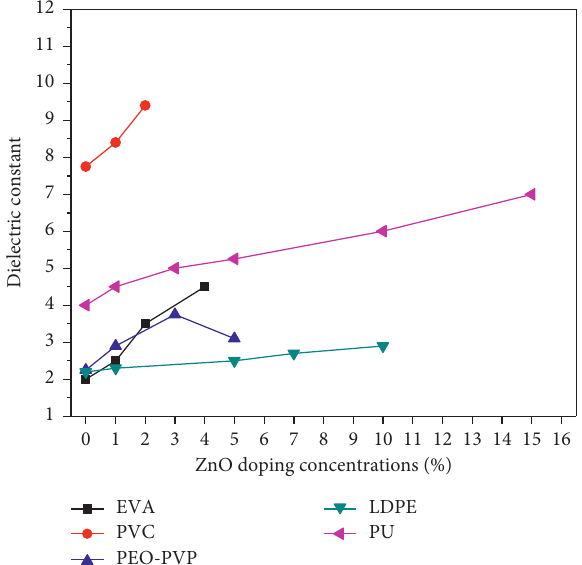
Figure 13: Variation of the dielectric constant of various polymer- based ZnO nanocomposites with respect to doping concentration at 1 KHz